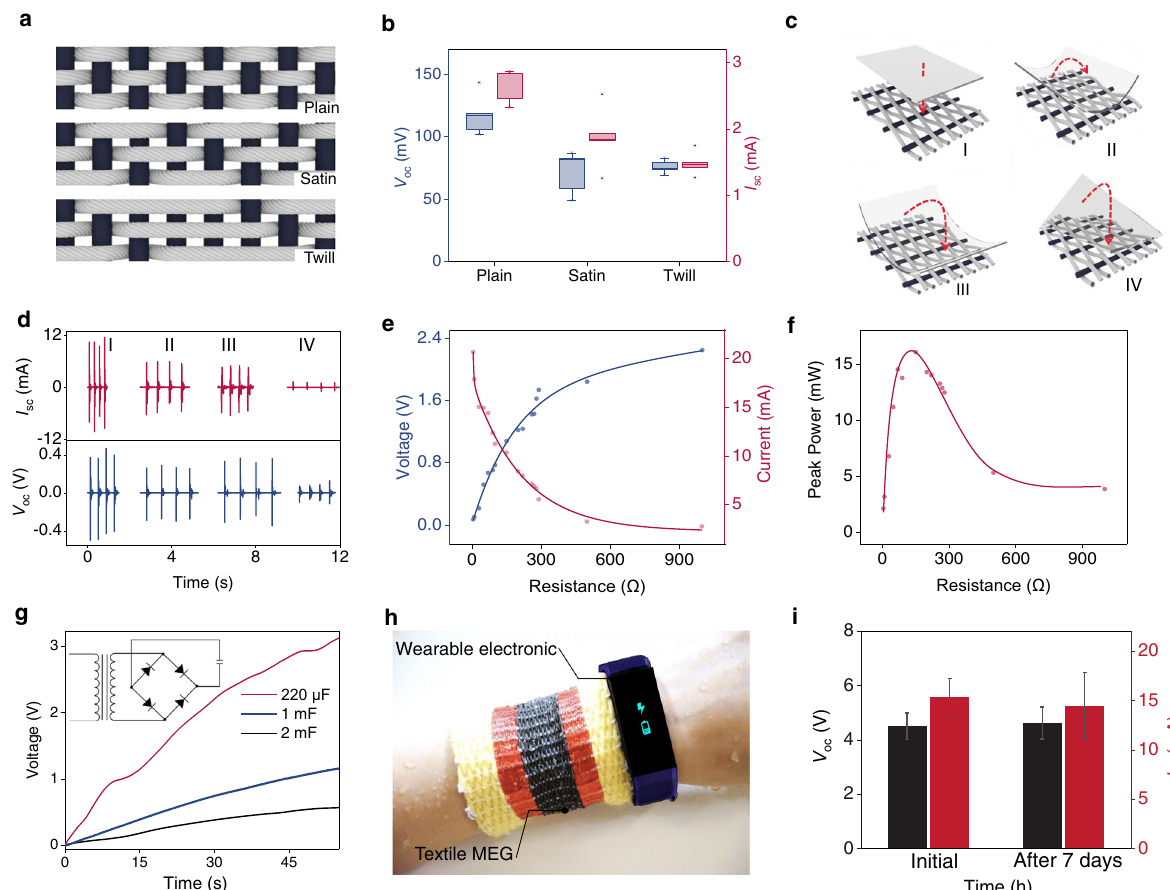
Fig. 3 Intrinsically waterproof textile for wearable power generation. a , b Schematics showing the three different weaving patterns ( a ) and the corresponding measured electrical signals ( b ) of the textile MEG. Boxplots show maximum, minima, median, and upper and lower quartiles. c , d Schematics showing four excitation modes of the textile MEG ( c ) and the corresponding measured electrical signals ( d ). e Dependence of the output voltage and current of the textile MEG on the external load resistances. f Dependence of the power on the external load resistances. g Charging commercial capacitors up to 3 V. h Schematic of the textile MEG mixed with wool fi bers driving a wearable biosensor system. i Electric outputs of the textile MEG before and after being submerged in water for 7 days. Data are mean ± SD; n =